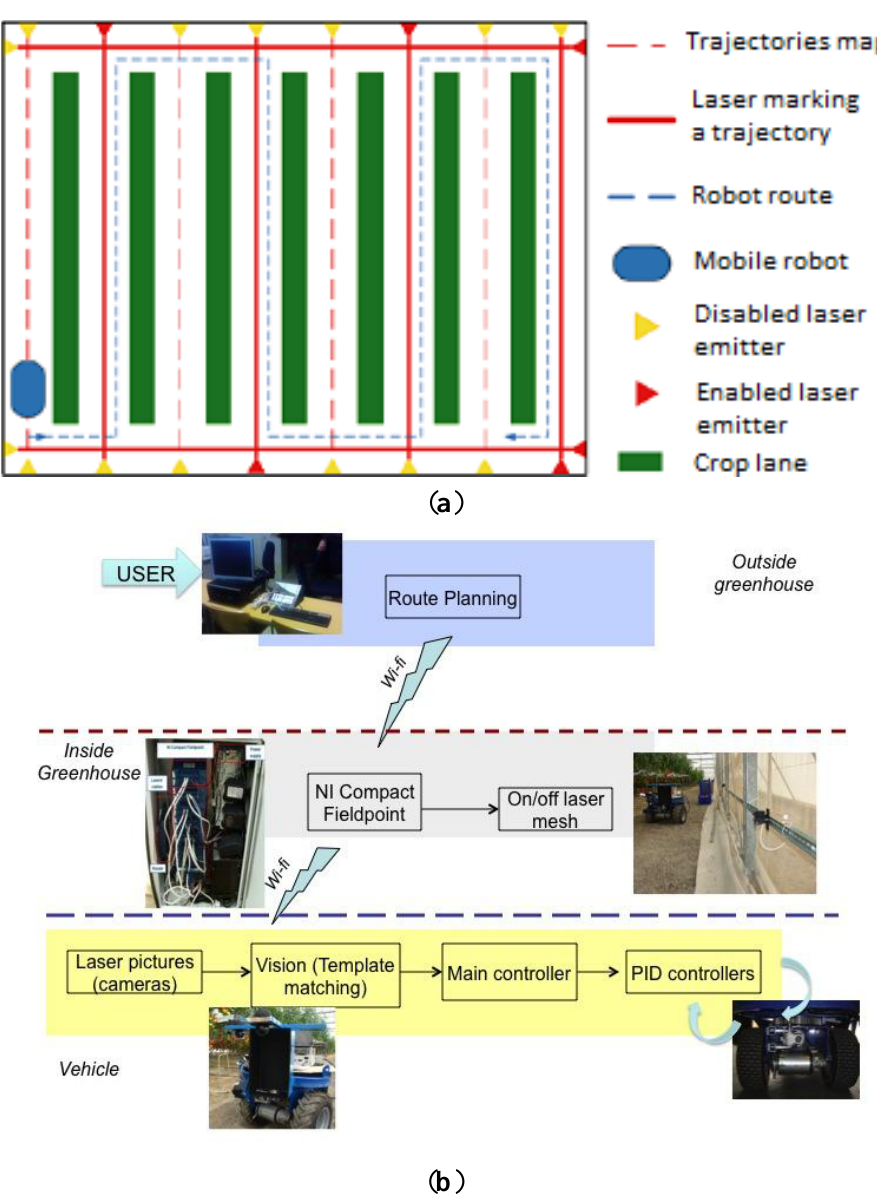
Figure 5. ( a ) Laser mesh in a typical Spanish greenhouse layout. ( b ) Elements composing the control